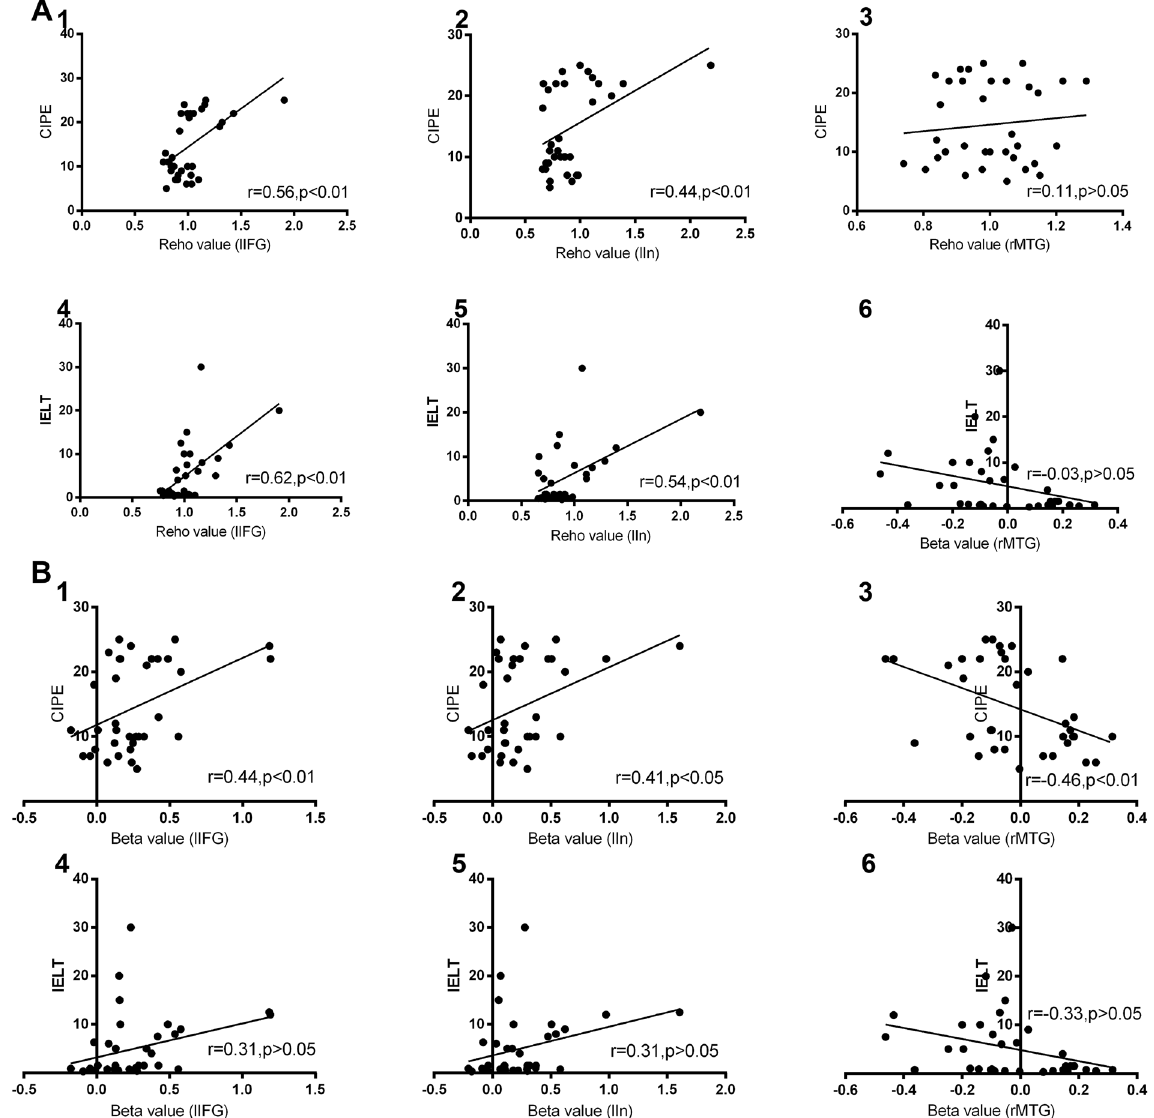
beta value in the lIn correlated with the CIPE and IELT; B.3 and B.6: the beta value in the rMTG correlated with the CIPE and IELT. rMTG: right middle temporal gyrus; lIFG: left inferior frontal gyrus; lIn: left insula, CIPE = Chinese Index of Premature Ejaculation; IELT = intravaginal ejaculatory latency